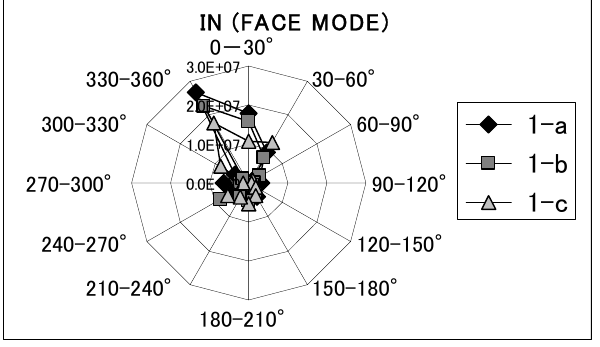
Fig. 11 Distributions of the interval RMS value of static pressure fluctuation (at the inlet of blade, FACE MODE). The unit is [mV/s 2 ].